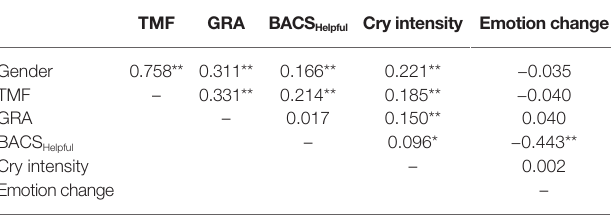
TABLE 3 | Correlations between self-reported gender, gender roles, beliefs that crying is helpful (BACS Helpful ), crying intensity, and emotion change following